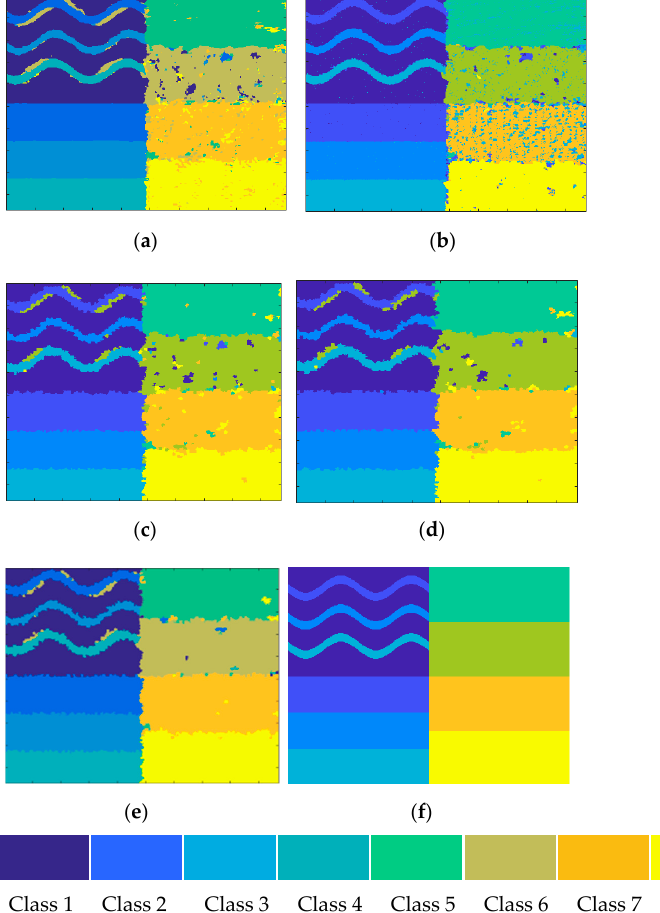
Figure 5. The classification results on the synthetic SAR image. ( a ) CNN. ( b ) CNN-MRF. ( c ) CNN-SP. ( d ) RCC-MRF. ( e ) Proposed method. ( f ) Ground truth. ( d ) RCC-MRF. ( e ) Proposed method. ( f ) Ground